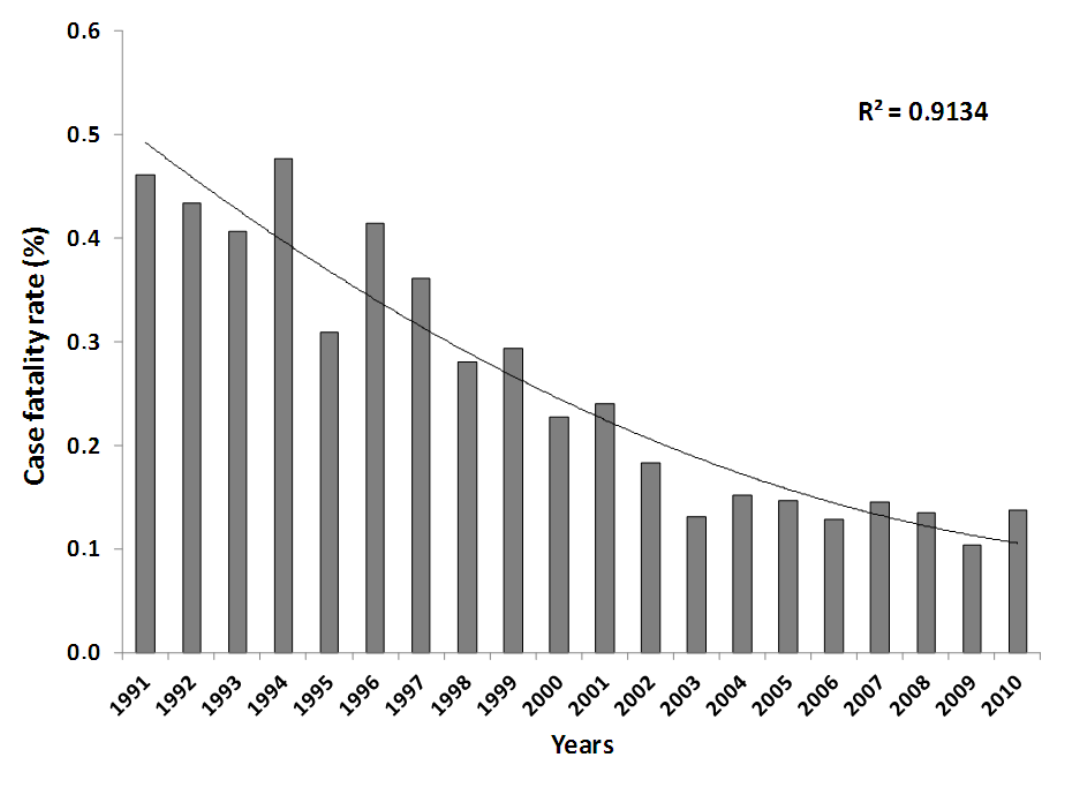
Figure 9. Trend of annual case fatality rate due to scorpion stings in Algeria from 1991 to 2010.